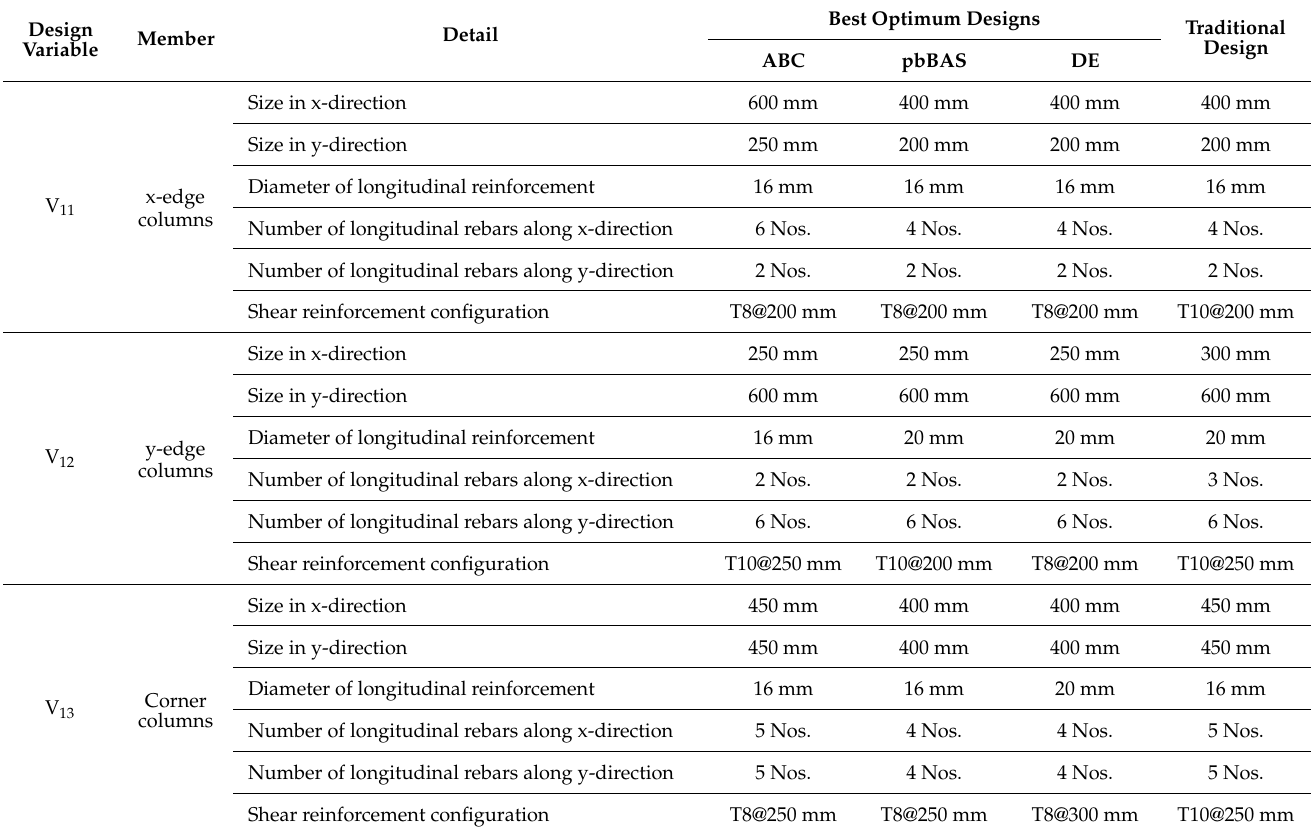
Table 26. The best optimum values of columns variables obtained by each metaheuristic algorithm for the three-segment type folded plate roof